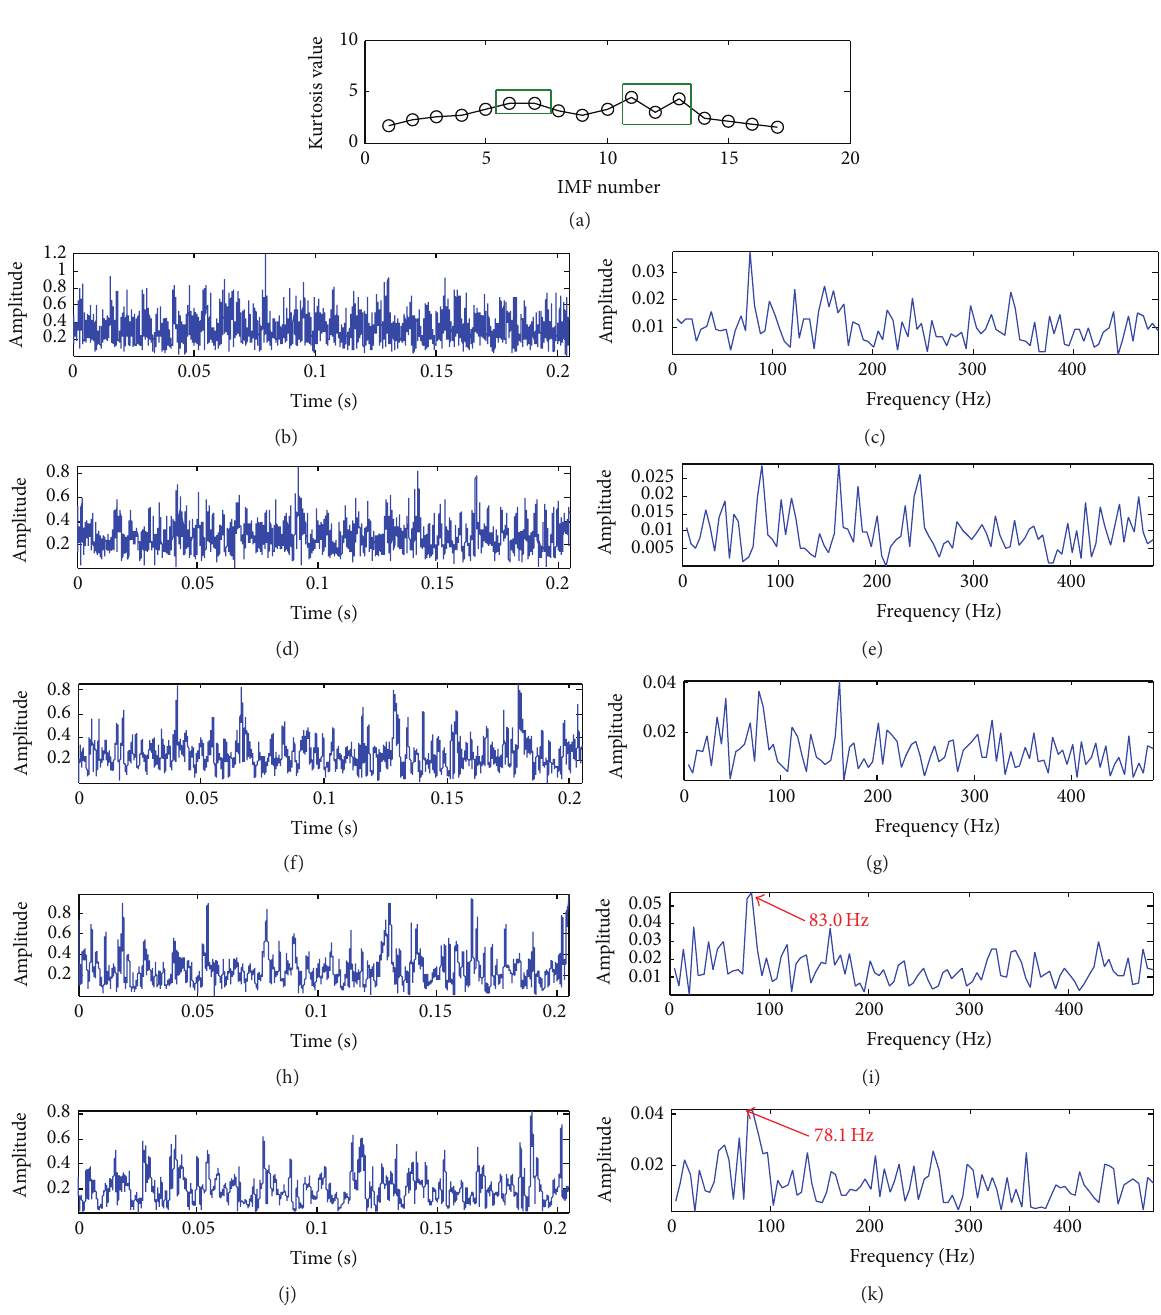
Figure19:AnalyzedresultsofvibrationsignalinFigure 15(a)byEMD-baseddemodulationmethod:(a)kurtosiscurveof17IMF;(b)envelope waveform of IMF3; (c) envelope spectrum of IMF3; (d) envelope waveform of IMF4; (e) envelope spectrum of IMF4; (f) envelope waveform of IMF5; (g) envelope spectrum of IMF5; (h) envelope waveform of IMF6; (i) envelope spectrum of IMF6; (j) envelope waveform of IMF7; (k) envelope spectrum of